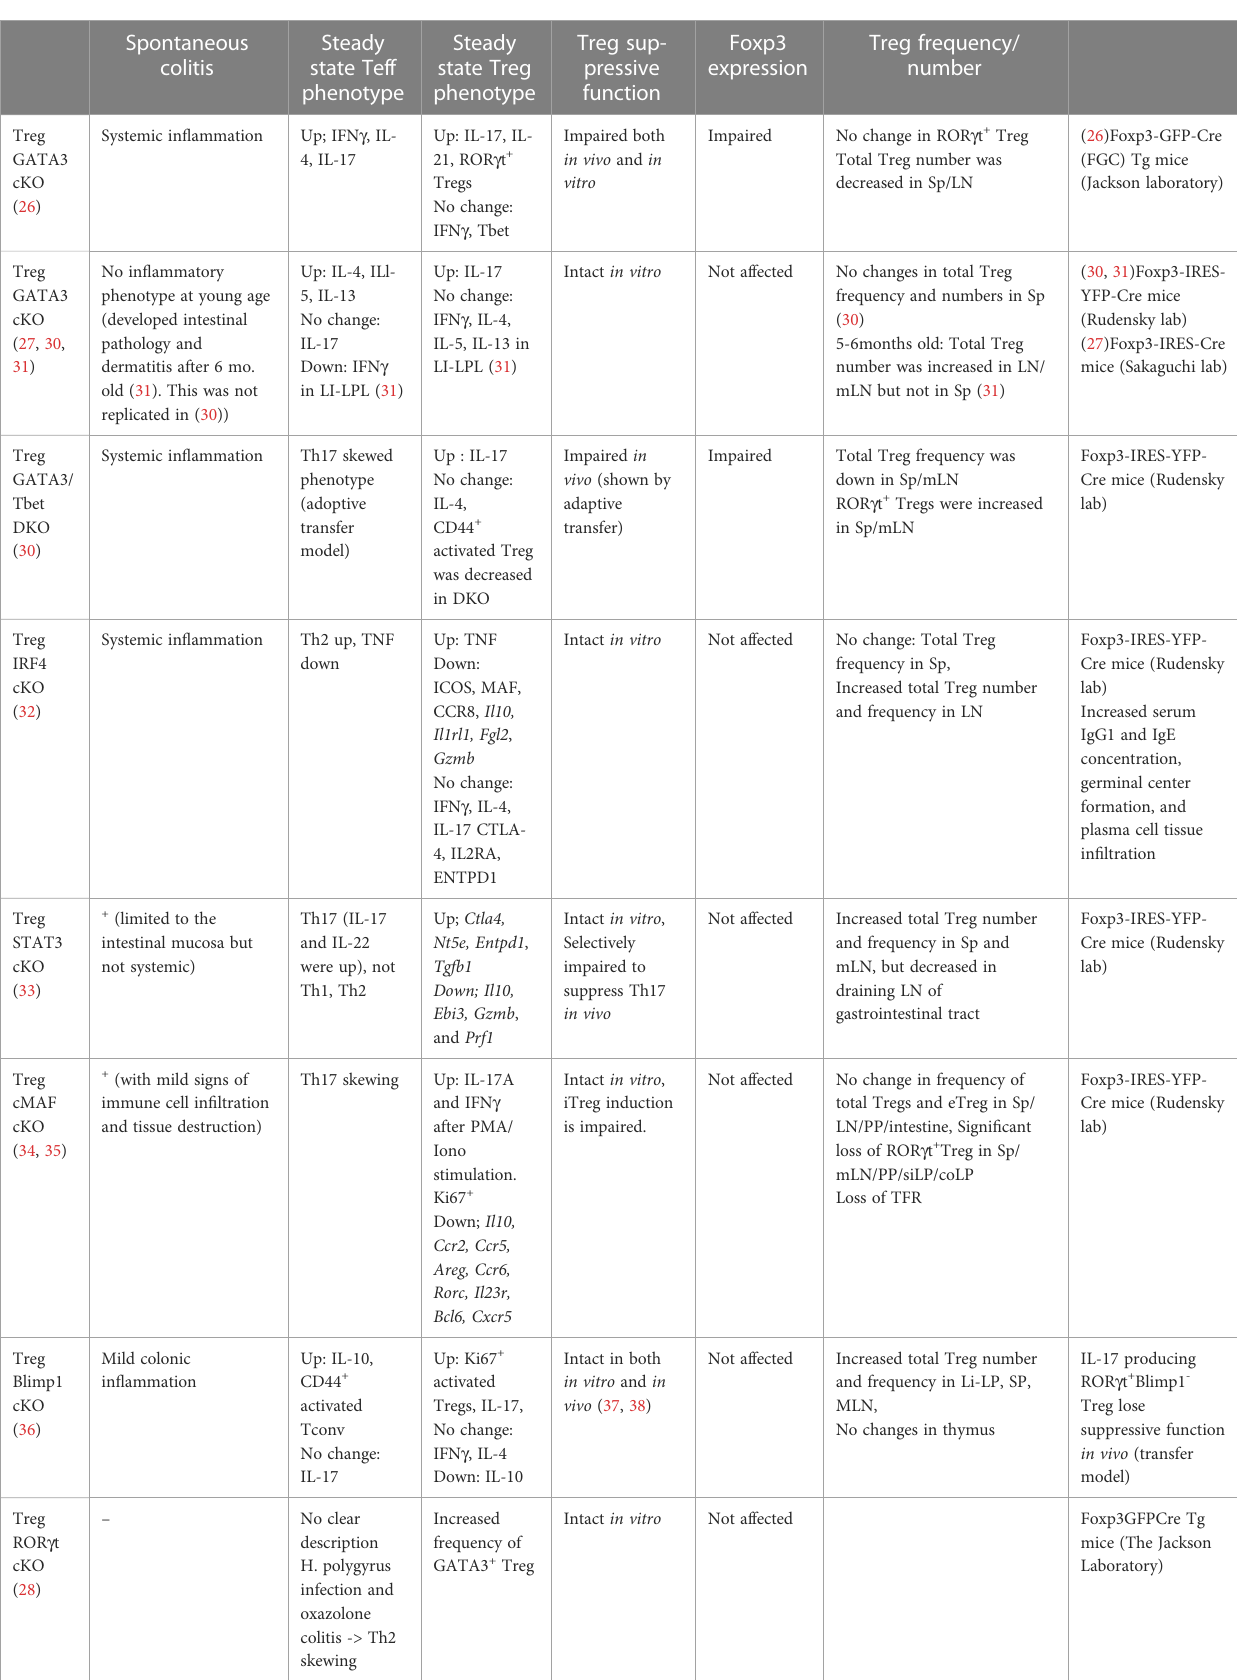
TABLE 1 The role of core tissue Treg regulatory factors in vivo in